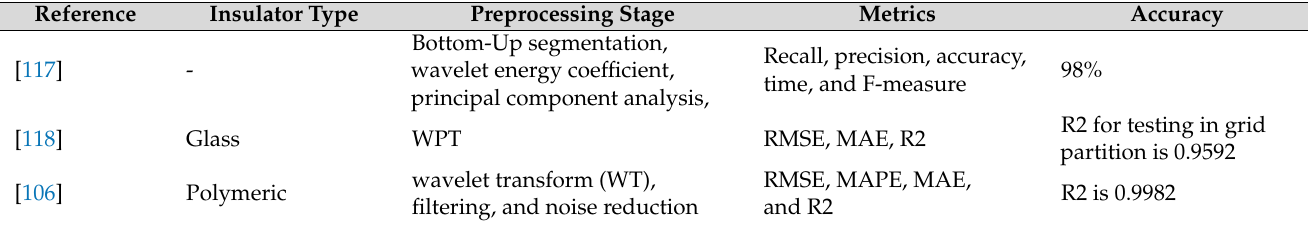
Table 9. The accuracy of using different signal processing techniques for acoustic signals in detecting contamination